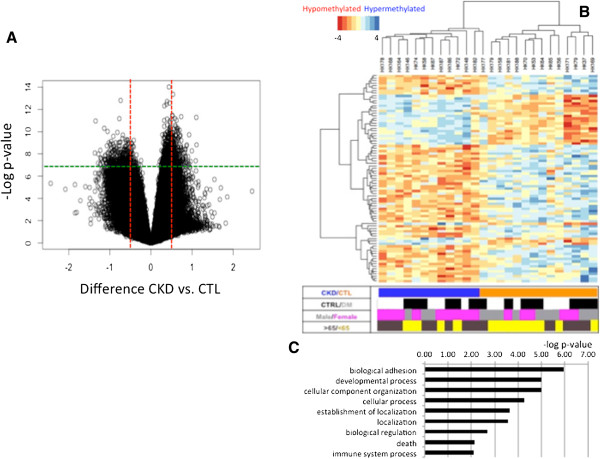
Statistically significant cytosine methylation differences in chronic kidney disease. (A) Volcano plot analysis of cytosine methylation differences. The x-axis represents the relative cytosine methylation difference of control (CTL) versus CKD samples, the y-axis represents the negative log2 of the P-value of that locus. The mean P-value and mean difference of 1.3 million loci present on the chips are plotted on the graph. The green and red lines represent the statistical criteria used for further analysis (P-value and fold change, respectively). (B) Hierarchical cluster analysis of the differentially methylated regions. Each column represents changes from one individual kidney sample; blue indicates hypermethylation in CKD, while red represents hypomethylation in CKD. The chart below shows the clinical parameters of the samples: glomerular filtration rate, diabetes status (DM, diabetes mellitus), sex, and age (aged >65 years or <65 years). (C) Gene Ontology analysis of the 1,535 DMRs mapped to unique genes using DAVID gene ontology annotation groups (biological process level 1 annotation).